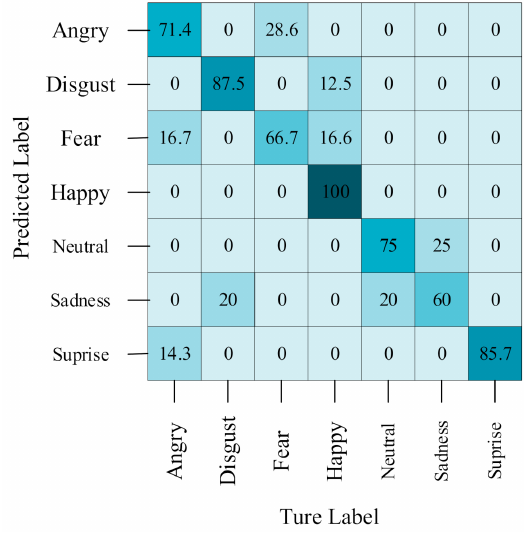
Figure 8. Test confusion matrix of MMI database.